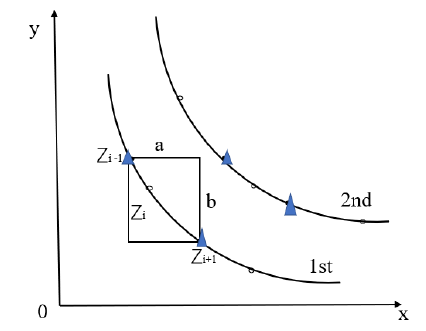
Figure 8. Individual crowding calculation.